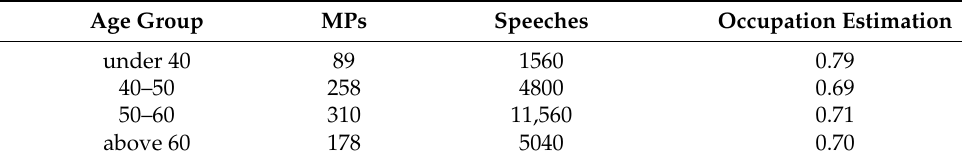
Table 4. Impact of the age groups on the occupation classification.